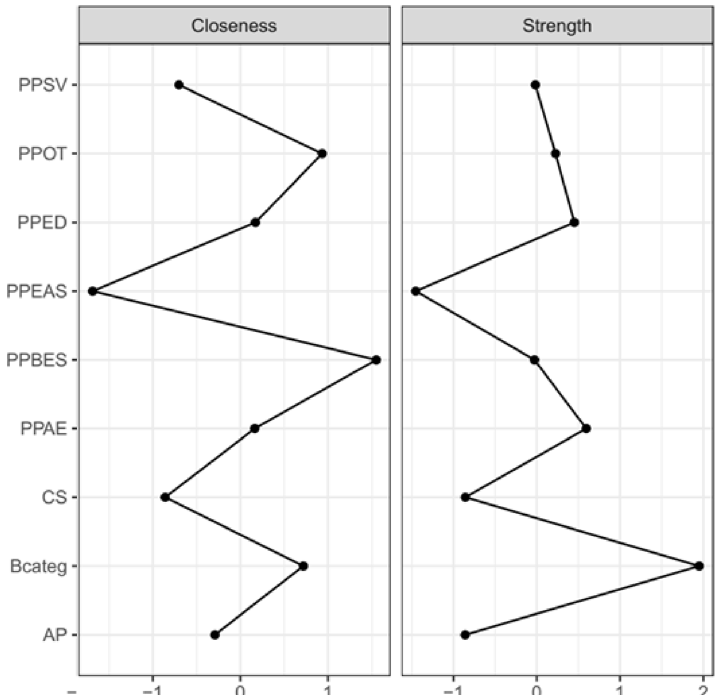
Fig. 2 Measures of centrality between the constructs of Positive Psychology and the indicators of depression. Legend: Measures of values standardized with zero mean, “closeness” represents the variables with the highest number of weighted connections, and “expected influence” represents the variables with the greatest positive influence over the others